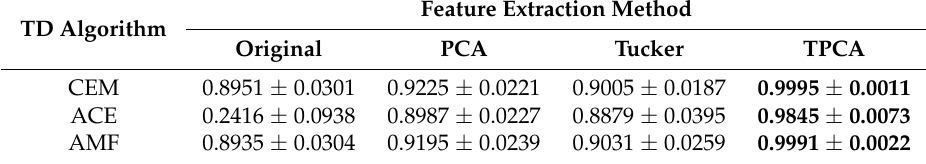
Table 4. AUCs of ROC curves for TD for synthetic data with different feature extraction methods repeated 20 times.